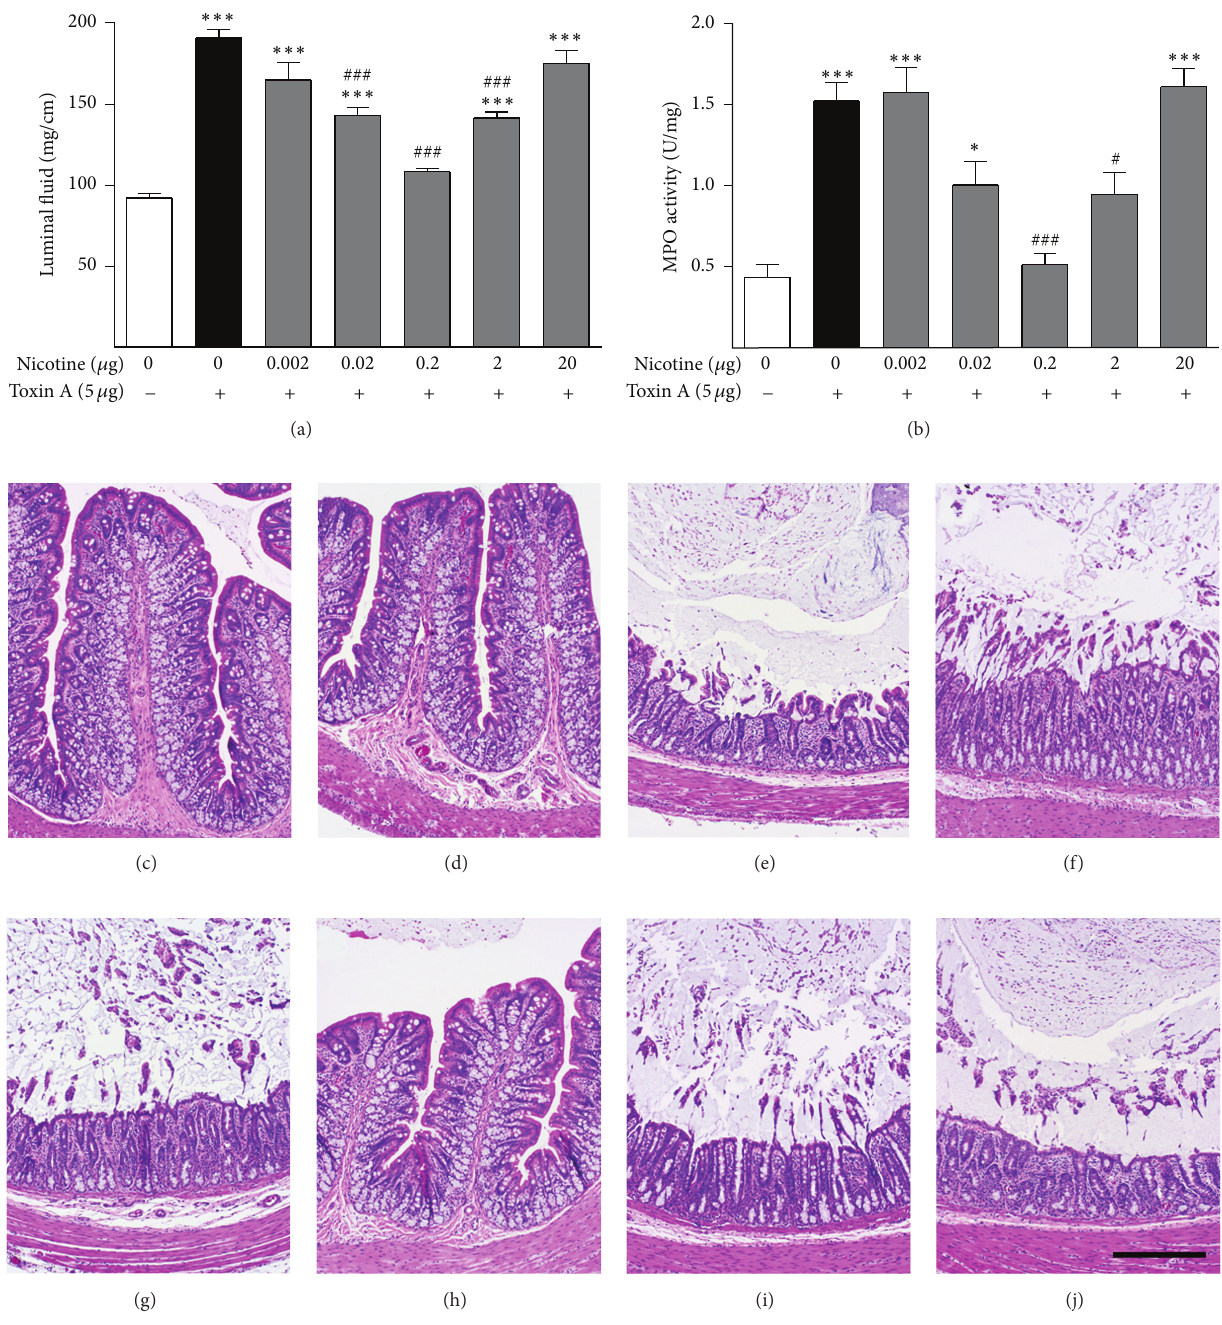
Figure 1: Dose-response effects of nicotine on toxin A-induced (5 𝜇 g) colonic luminal fluid accumulation (a), MPO content (b), and histopathology (c–j). Toxin A strongly and significantly stimulates colonic luminal fluid accumulation and MPO activity. Nicotine has a biphasic effect on these actions of toxin A. At low doses, nicotine dose-dependently inhibited these effects of toxin A. At higher doses, nicotine inhibited toxin A colitis progressively less but never increased inflammation beyond the effect of toxin A alone. ∗∗∗ 𝑃 < 0.001 versus control; ### 𝑃 < 0.001 versus toxin A; 𝑁 = 6 . (c) Control section illustrating the normal histology of the rat colon. (d) Nicotine (0.2 𝜇 g) alone has no effect on colonic histology. (e) Toxin A (5 𝜇 g) causes extensive inflammatory damage to the colon including loss of mucosal folding, distortion of crypts, surface ulceration, and influx of inflammatory cells including neutrophils. (f) Toxin A (5 𝜇 g) after pretreatment with 0.002 𝜇 g nicotine. This dose of nicotine had little effect on toxin A colitis. (g) Toxin A (5 𝜇 g) after pretreatment with 0.02 𝜇 g nicotine. This dose of nicotine had little effect on toxin A colitis. (h) Toxin A (5 𝜇 g) after pretreatment with 0.2 𝜇 g nicotine. This dose of nicotine appeared to protect almost completely against toxin A colitis. (i) Toxin A (5 𝜇 g) after pretreatment with 2 𝜇 g nicotine. This dose of nicotine had little effect on toxin A colitis. (j) Toxin A (5 𝜇 g) after pretreatment with 20 𝜇 g nicotine. This dose of nicotine had little effect on toxin A colitis. These results agree well with the effects of nicotine on toxin A-induced luminal fluid accumulation and MPO activity shown in (a) and (b). Line bar = 100 𝜇